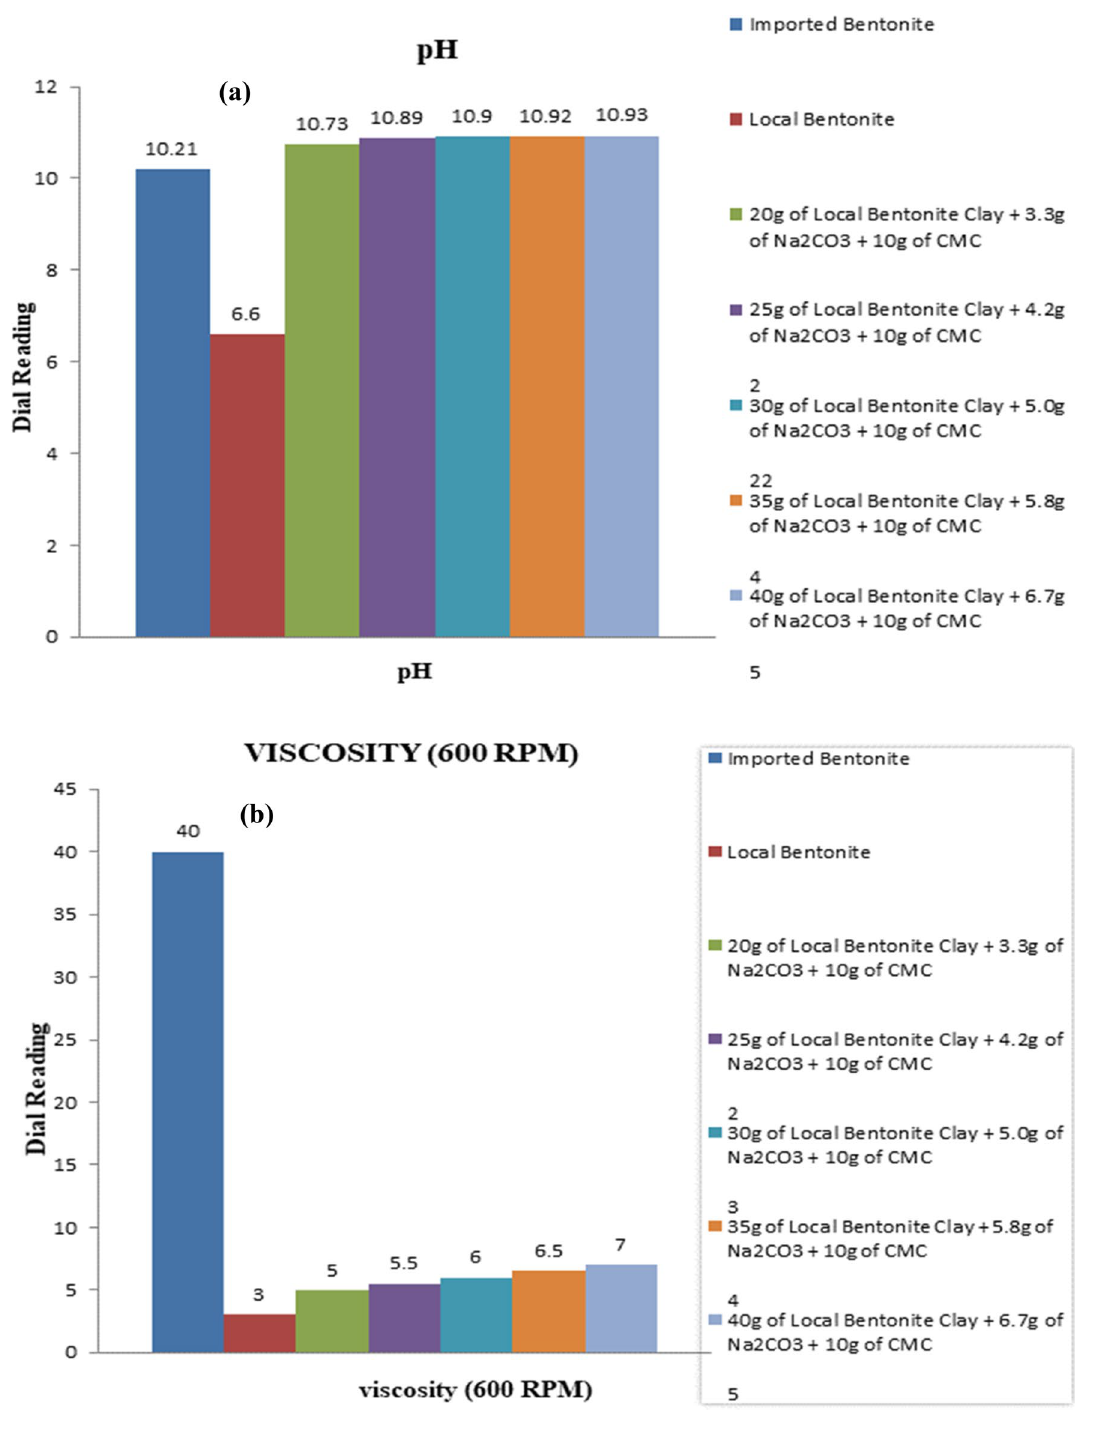
Fig. 9 Histogram showing the pH ( a ) and Viscosity at 600 RPM ( b ) of